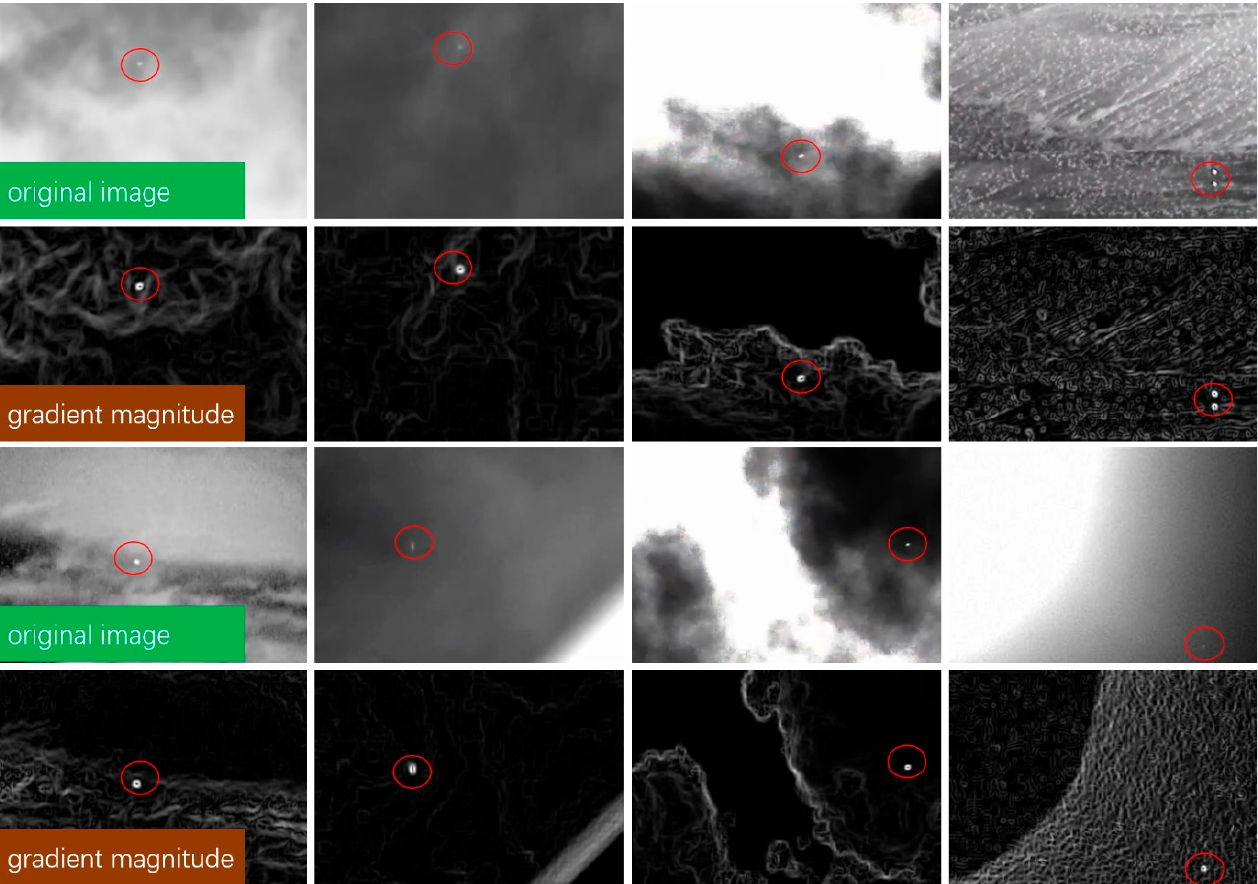
Figure 6. The original images and their gradient magnitude images. The images in the first and third rows are the original image, and the images in the second and fourth rows are the gradient magnitude images. Red circles highlight the targets in the images.